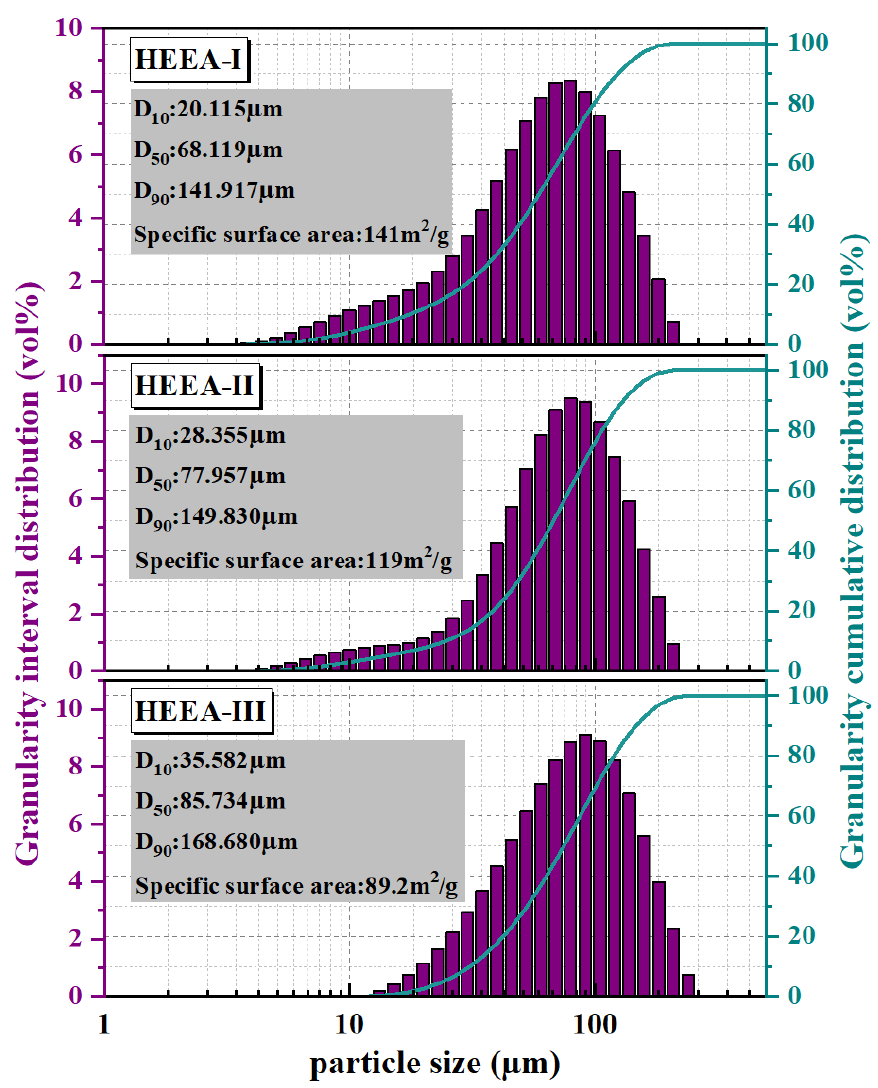
Figure 8. Particle size distribution of high-energy expansion agent admixture.